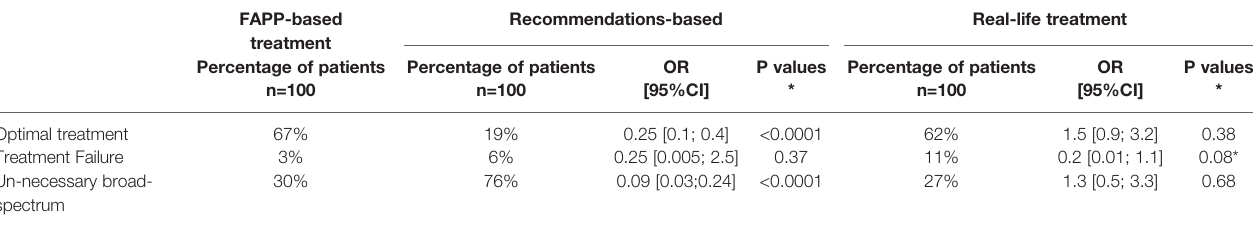
TABLE 3 | Adequation of the spectrum of empirical antimicrobial therapy with pathogens found in culture.